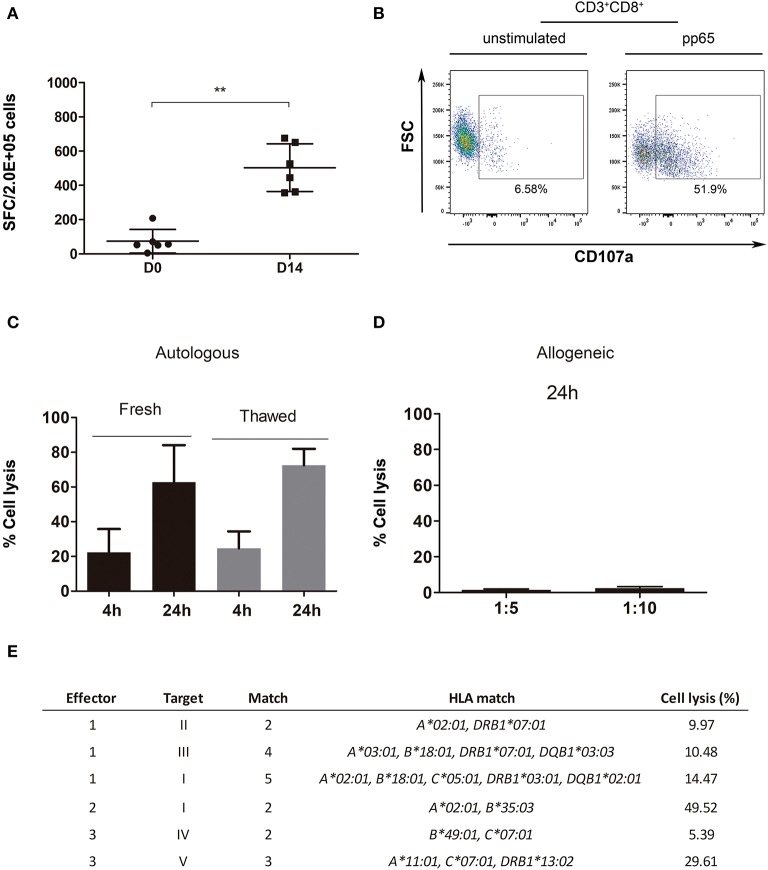
Potency and functional assays performed with the expanded product. (A) IFN-γ ELISPOT for D0 and D14 thawed cells (n = 6). (B) Example of a degranulation assay (CD8+CD107a+) dot plot for effector cells (VST), unstimulated (left plot) and stimulated with pp65 (right plot). (C) Cytotoxicity assay representation for pp65-pulsed autologous blasts specific lysis [4-h ratio, 1:5 (T:E); n = 3; 24-h ratio, 1:5 (T:E); n = 2]. (D) Cytotoxicity assay representation for irradiated allogeneic blasts unspecific cell lysis with 2–3 match (n = 6, fresh n = 2, thawed n = 4). (E) Cytotoxicity assay representation for effector cells (E): VST, cocultured with target cells (T), pp65-pulsed allogeneic blasts. Percentage of cell lysis calculated from a ratio of 1:10 (T:E). **p < 0.01 (Mann-Whitney test).